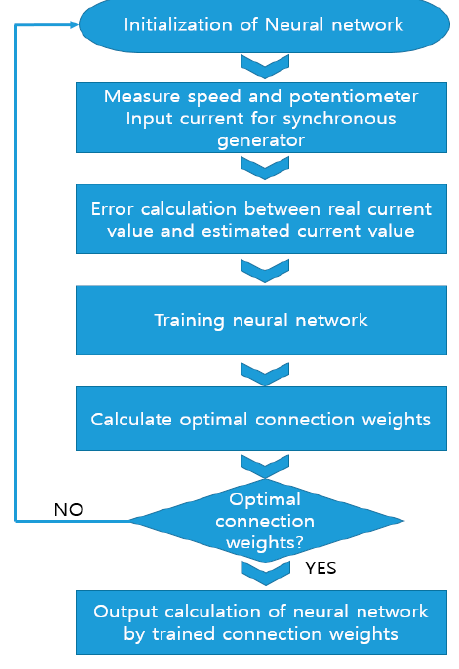
Figure 8. Flowchart of training algorithm for neural network .